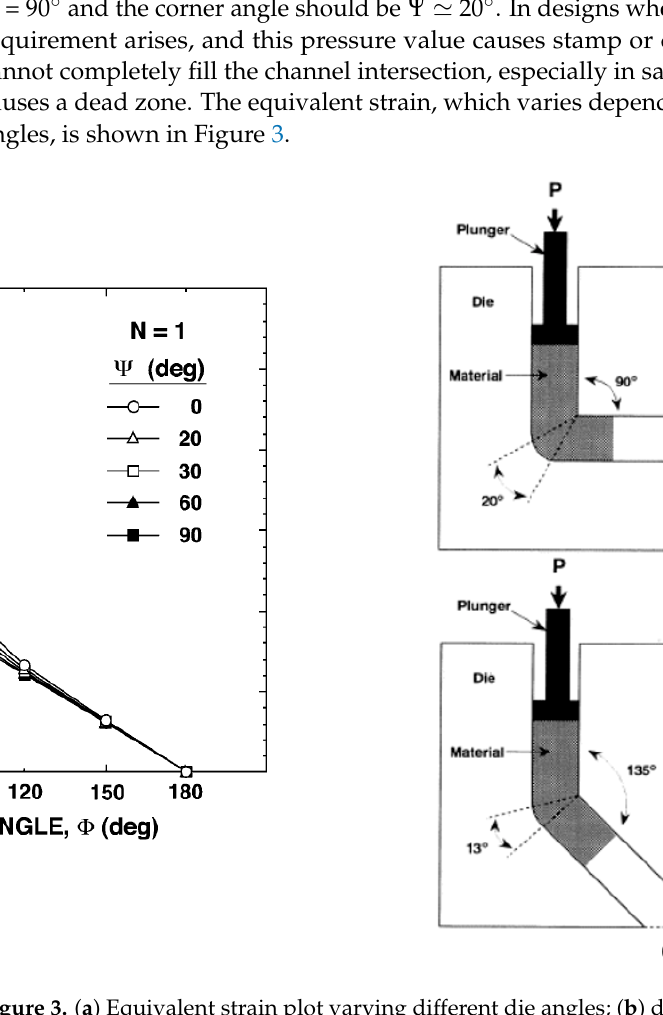
Figure 2. Schematic illustration of ECAP process [39].